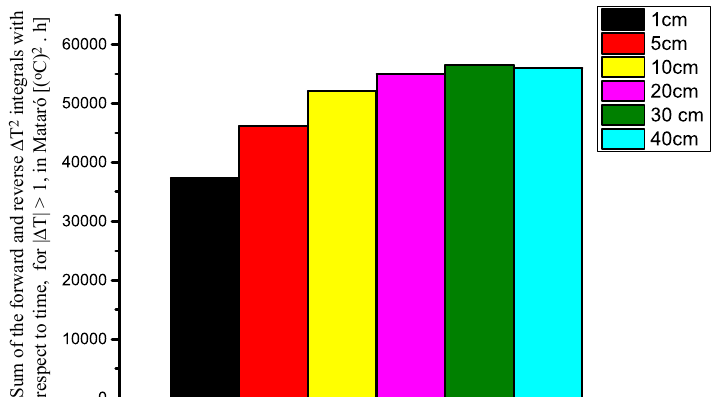
Figure 12. Sum of the “forward” and “reverse” integrals of ∆ T 2 with respect to time (for | T − T | ≥ 1 ◦ C), at various depths, for 205 days (from 23 June 2015 to 13 January 2016), plate depth in Mataró.